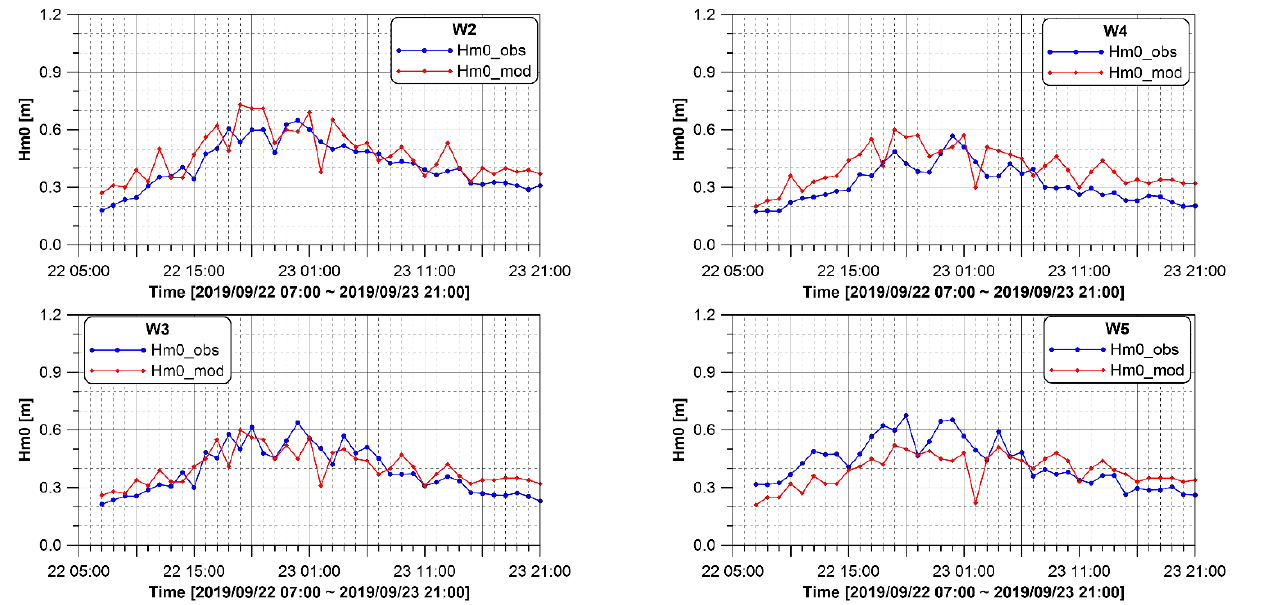
Figure 15. Comparison of wave height ( H m 0 ) between the observational (blue) and modeled (red) data at the four wave stations inside Pohang New Port (W2, W3, W4, and W5) during the period of the wave event selected for AC from 05:00 on the 22 to 21:00 on 23 September 2019. Reasonable agreements are observed between the observational and modeled data, supporting the model validation.